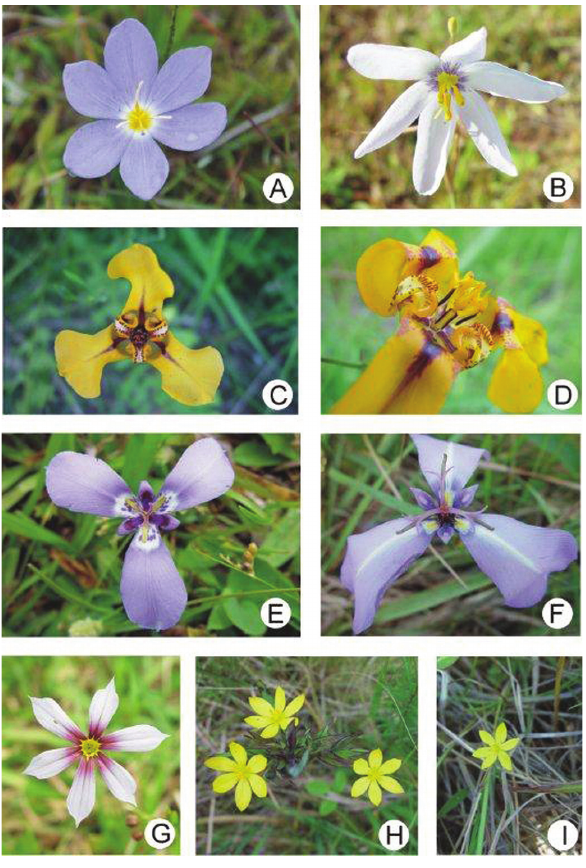
Figure 1 - Flowers of species cited in this study: (A) Calydorea crocoides Ravenna; (B) Calydorea alba Roitman & A. Castillo; (C) Cypella herbertii (Lindl.) Herb.; (D) Cypella fucata Ravenna; (E) Herbertia lahue (Molina) Goldblatt; (F) Herbertia pulchella Sweet; (G) Sisyrinchium micranthum Cav.; (H) Sisyrinchium palmifolium L.; (I) Sisyrinchium vaginatum Spreng. Photographs: L.